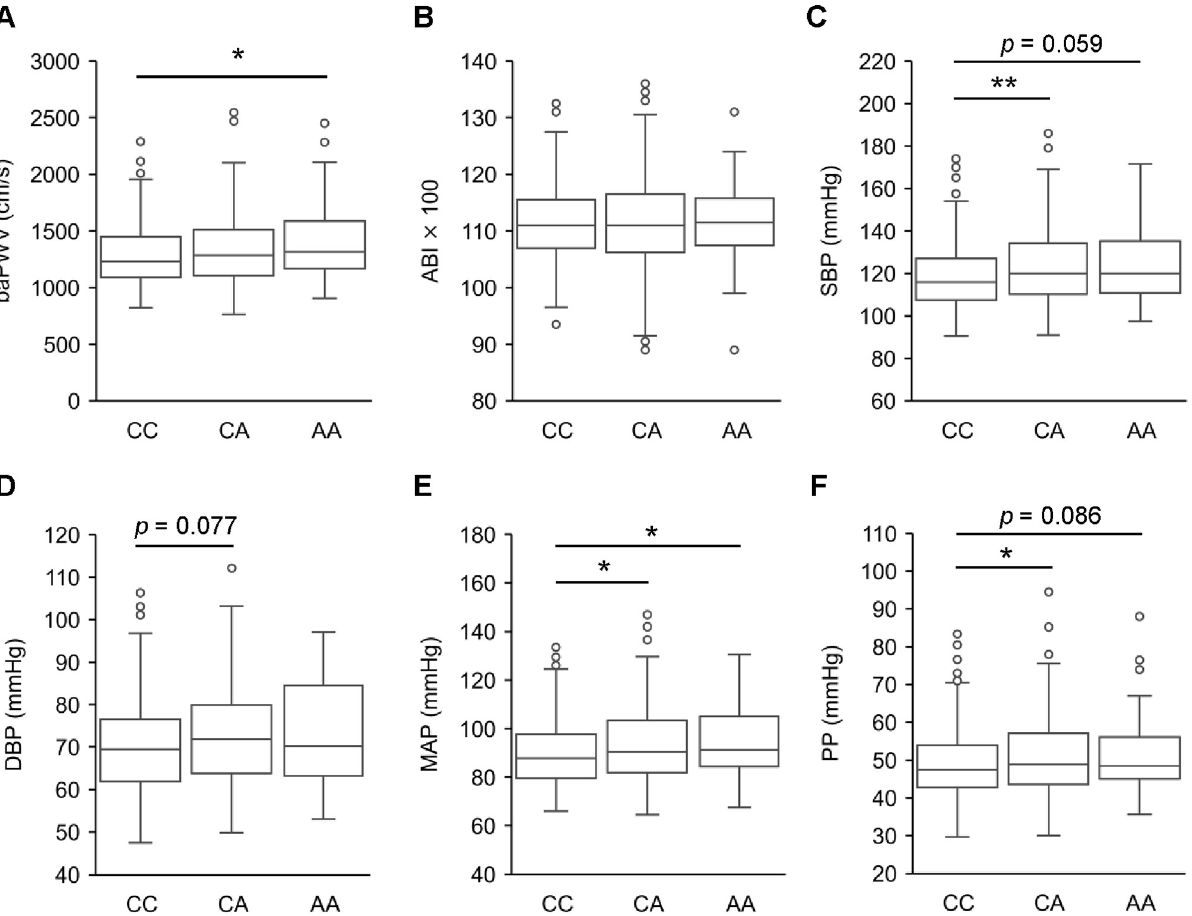
Fig 2. Arterial stiffness and blood pressure were affected by NRF2 SNP − 617. The boxplots with median, quartiles and min-max values of A) baPWV, B) ABI, C) SBP, D) DBP, E) MAP and F) PP were compared with respect to NRF2 SNP − 617. The data were analyzed by the Kruskal-Wallis test with a post hoc test by Holm. � p < 0.05, �� p <